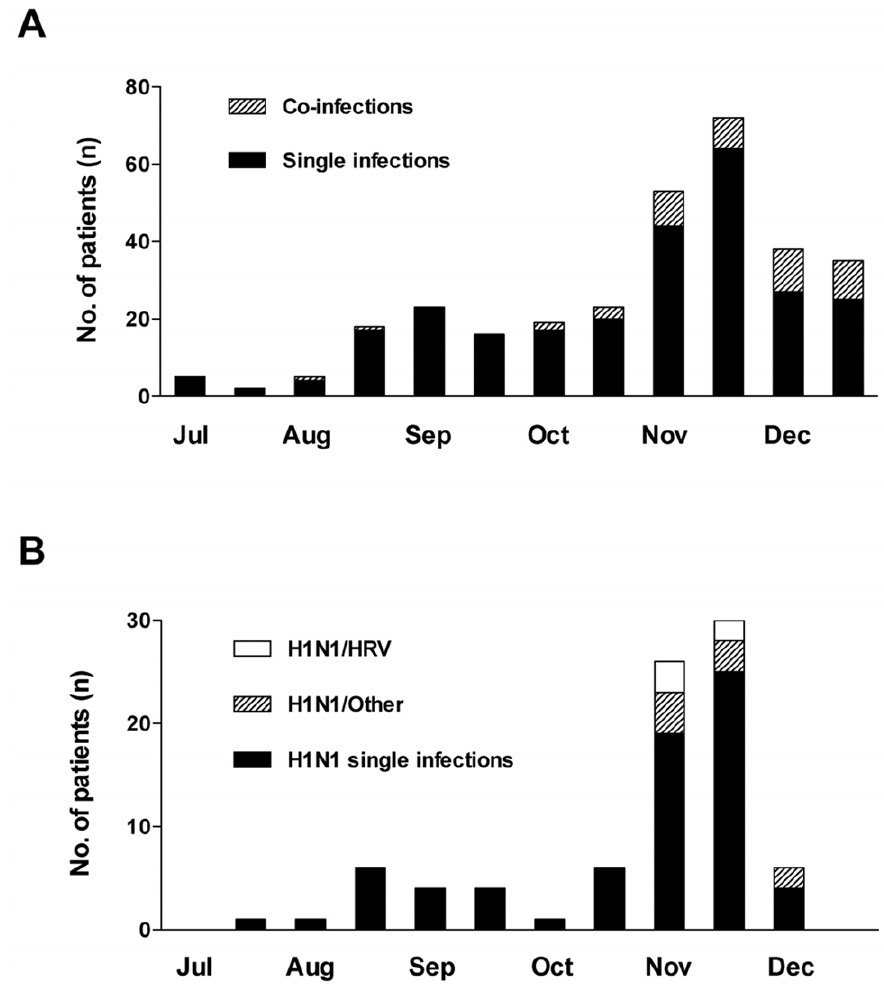
Figure 2. Co-infections over time. Number of children with co-infections over time in (a) all children and (b) H1N1-positive children. H1N1- positive co-infected children divided into co-infection with HRV (H1N1/HRV) and co-infection with other viruses